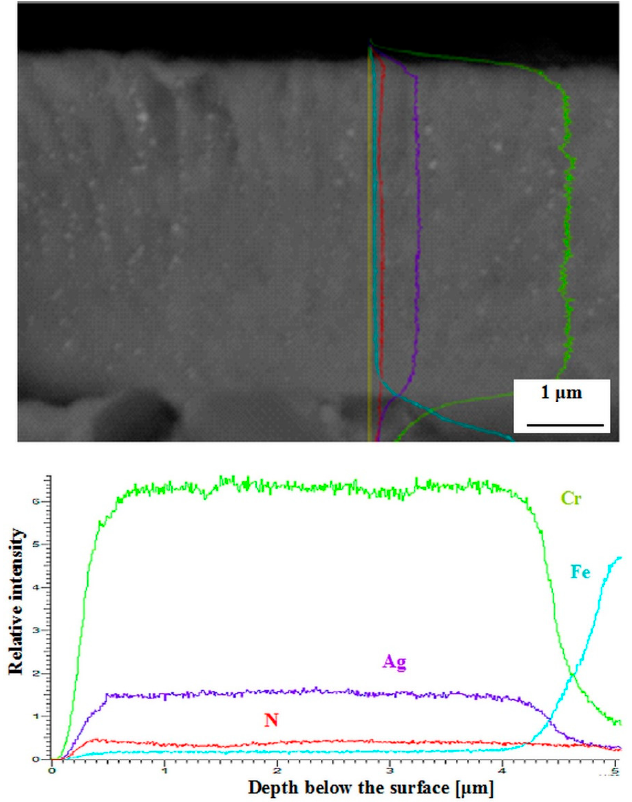
Figure 15. Concentration depth profiles of iron and the main coating elements, indicating a non- diffusive coating/substrate interface.